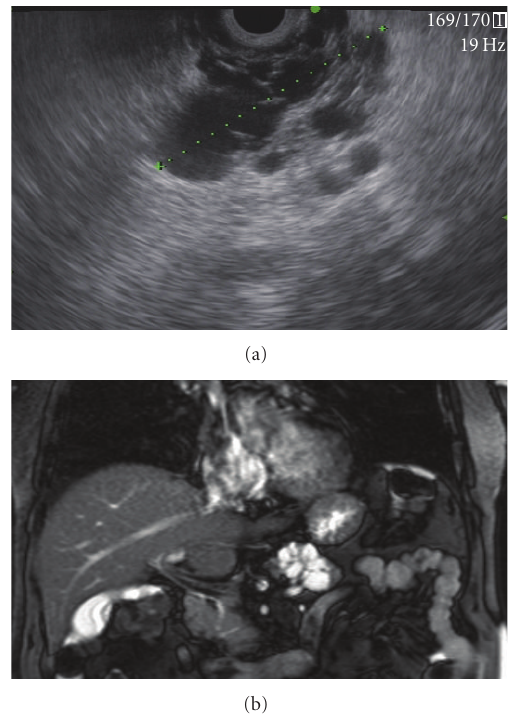
Figure 4: (a) EUS image of a serous cystadenoma in the head of the pancreas. (b) MRI image of a serous cystadenoma in the head of the